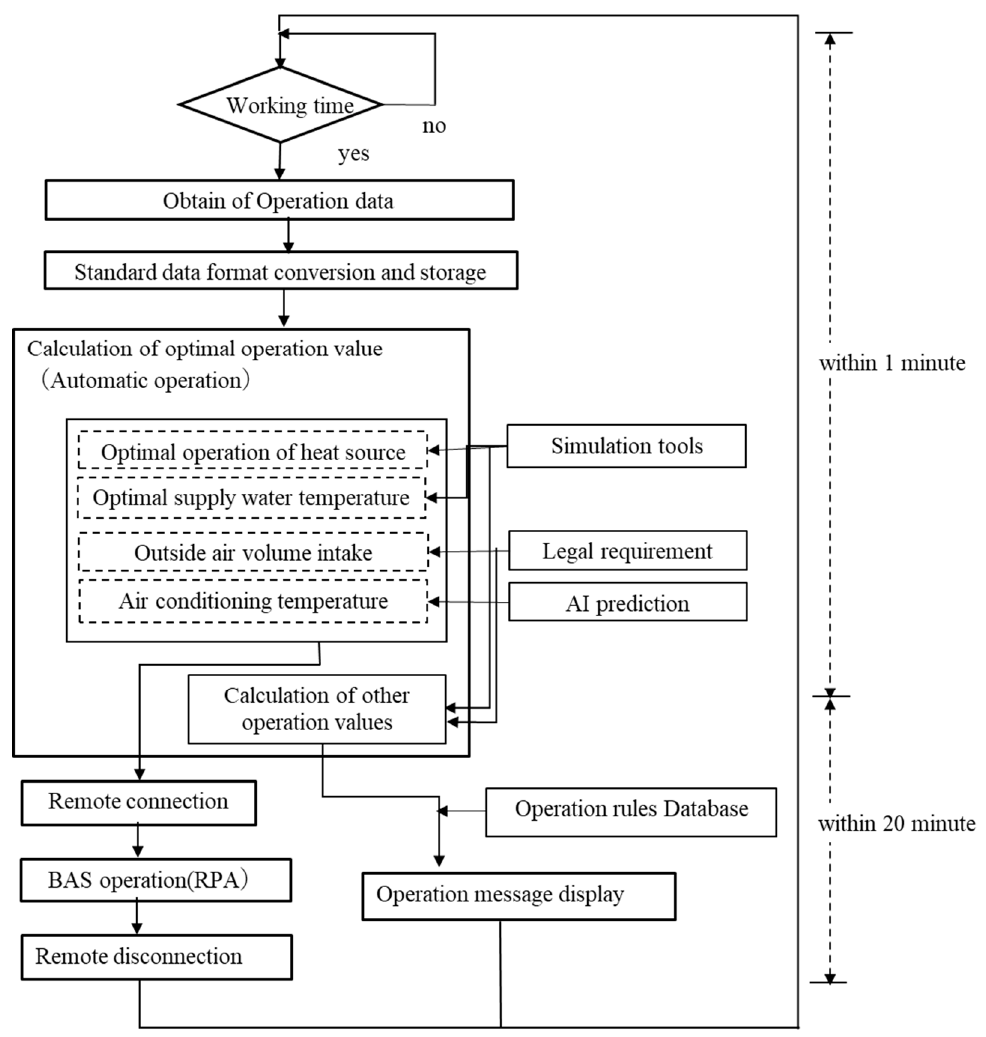
Figure 3. Operation flow.